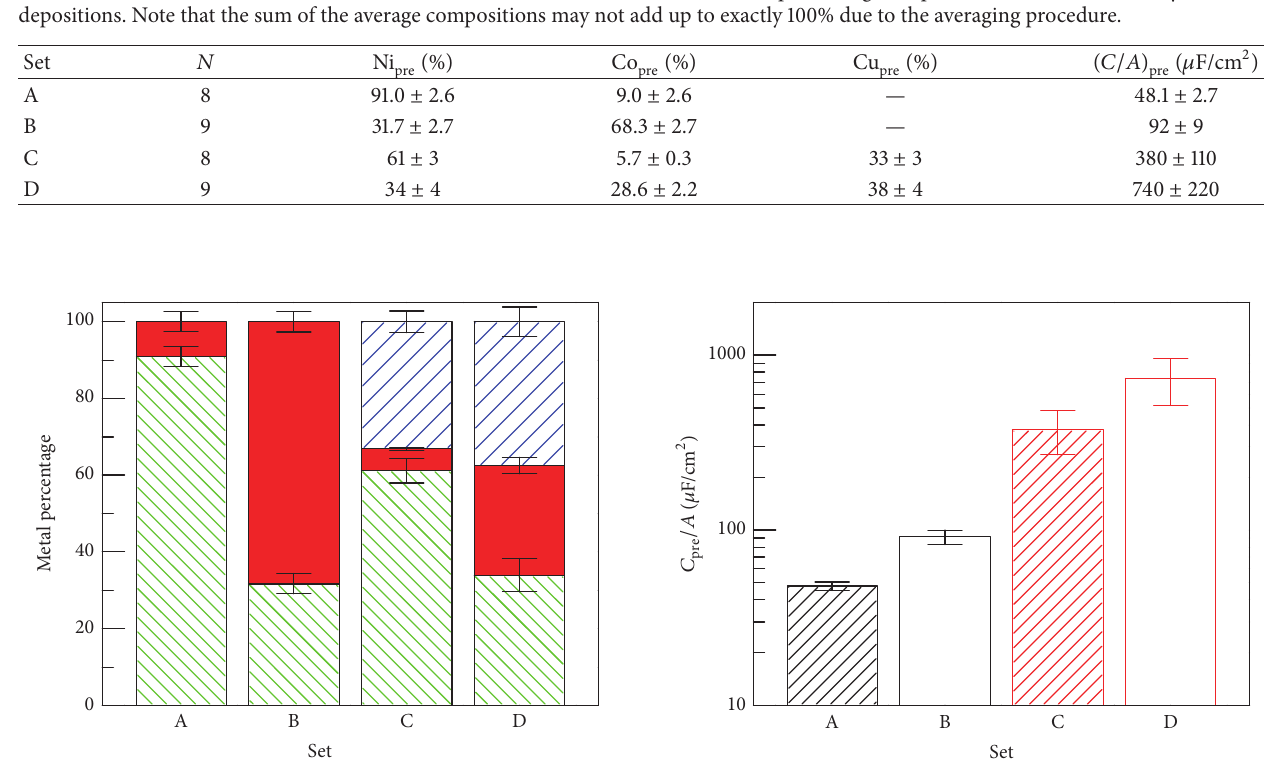
Figure 2: The average as-deposited specific capacitance for all four sets of